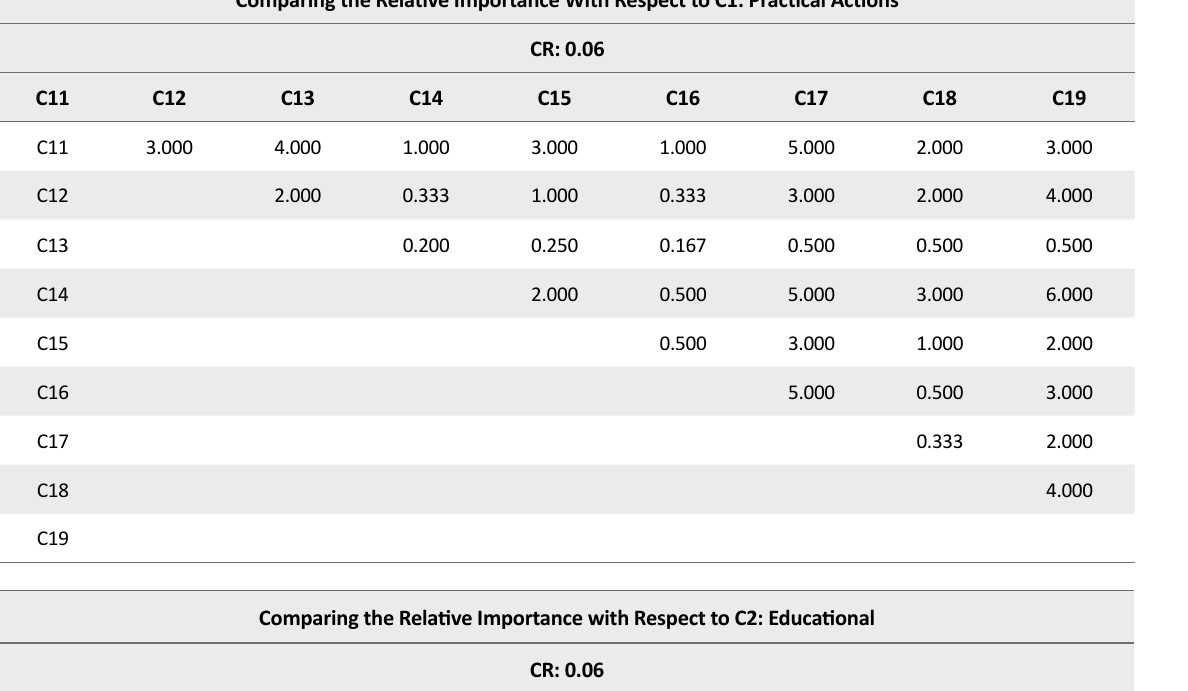
Table 2. Mean matrix of paired comparisons obtained from 15 surveys Comparing the Relative Importance With Respect to C1: Practical Actions CR: